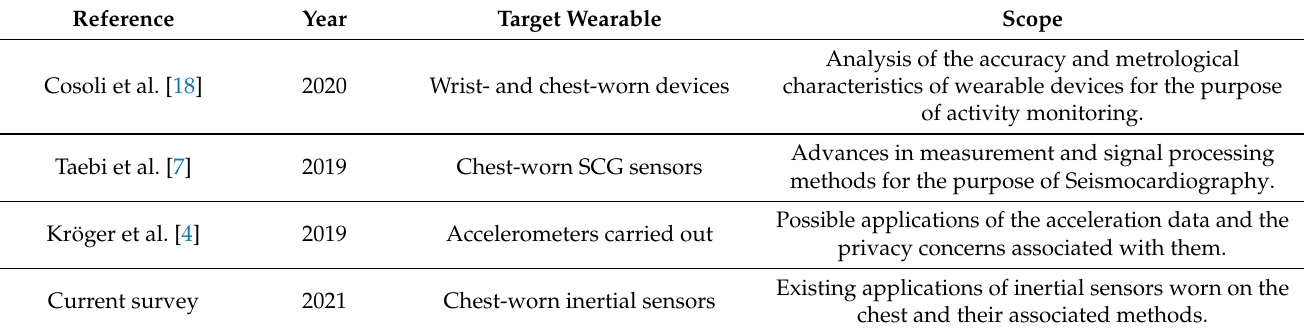
Figure 1. Area of interest of this survey. Table 1. List of the recent relevant work together with their